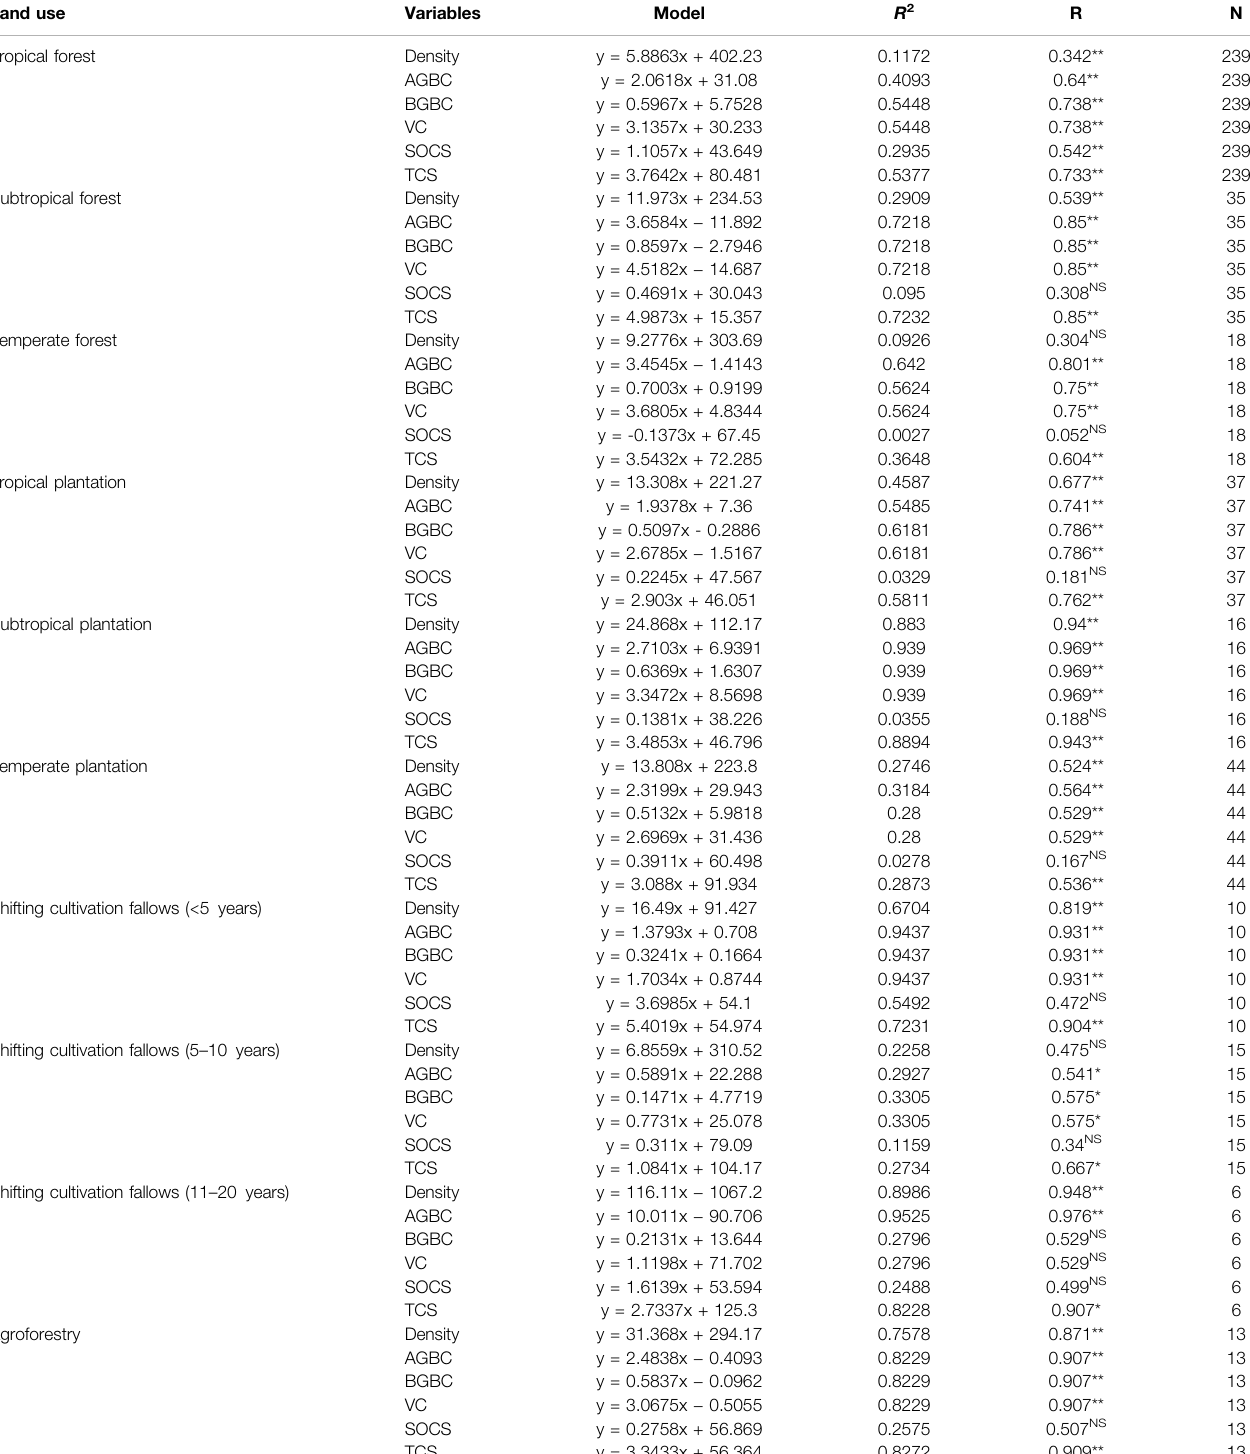
TABLE 4 | Relationships among density, aboveground biomass carbon (AGBC), belowground biomass carbon (BGBC), vegetation carbon (VC), soil organic carbon stock (SOCS), and total carbon stock (TCS) with basal area of the trees in different land-use sectors of Northeast